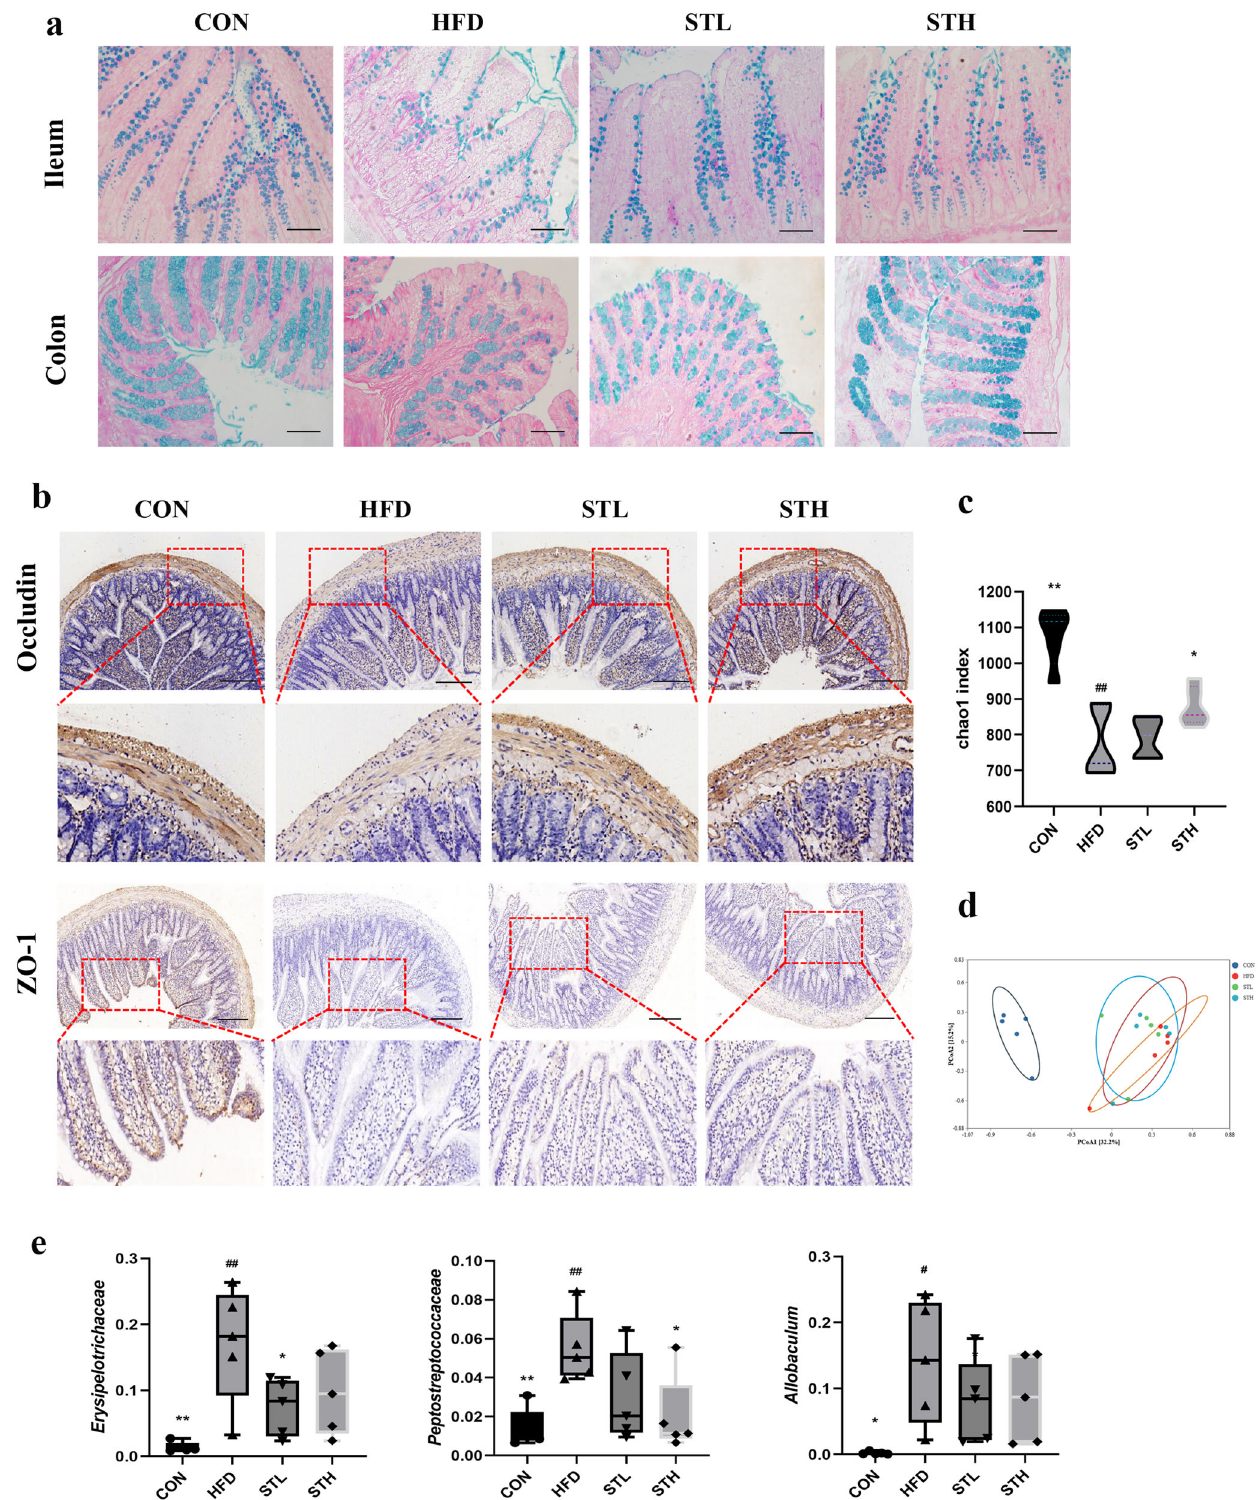
Fig. 2 ST improved intestinal barrier function in HFD fed rats. a AB-PAS staining of ileum and colon, Scale bar: 100 μ m; b immunohistochemistry of occludin and ZO-1 protein in ileum, Scale bar: 200 μ m; c the α -diversity index (chao1) of gut microbiota; d the β -diversity analysis (PCoA) of gut microbiota; e relative abundance of biomarker genra in family level and genus level. Data are expressed as mean ± standard deviation. One-way ANOVA was used to analyze statistical differences; compared with control group, # P < 0.05, ## P < 0.01; compared with HFD group, * P < 0.05, ** P <